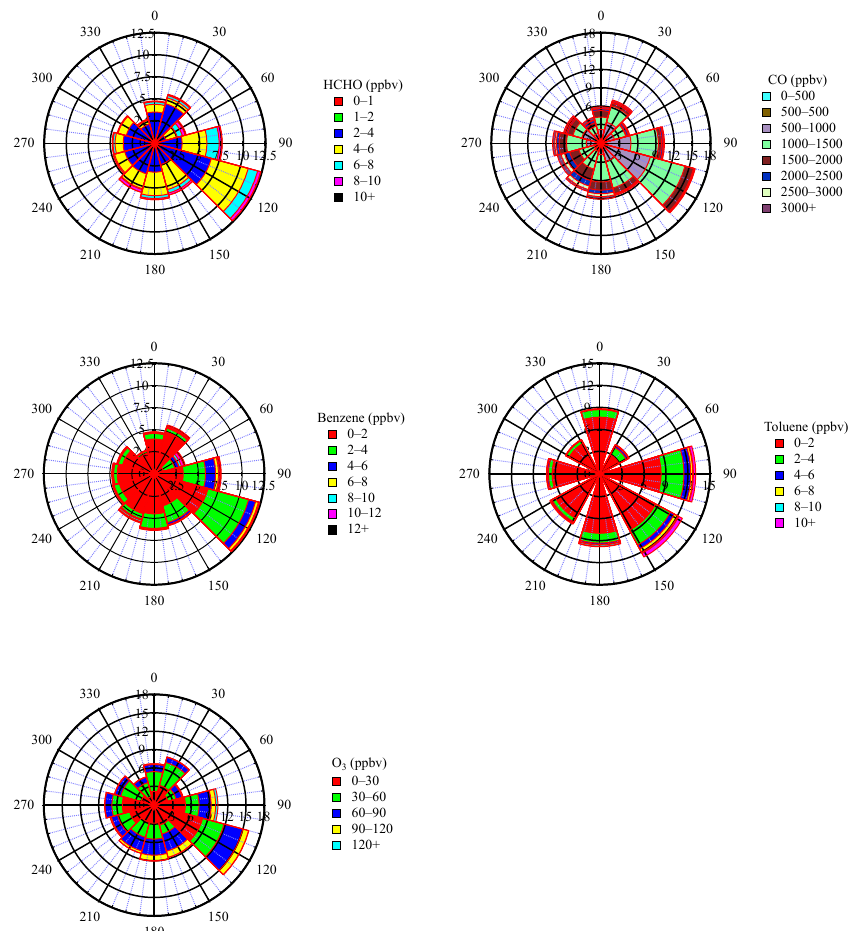
Figure 7. Rose plots of HCHO, CO, benzene, toluene, and O 3 . The radius represents the percentage of each air pollutant within a certain mixing ratio range. The spread angle denotes the wind